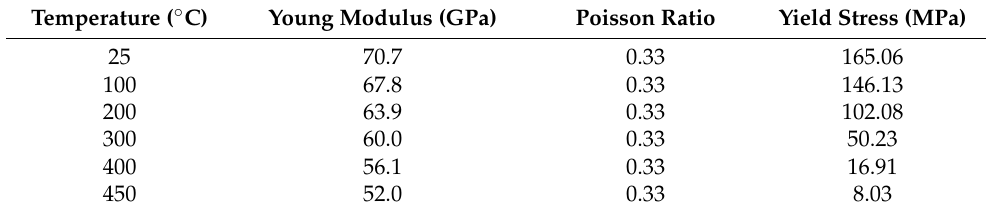
Table 3. Considered mechanical properties of 7075 aluminum with respect to temperature.